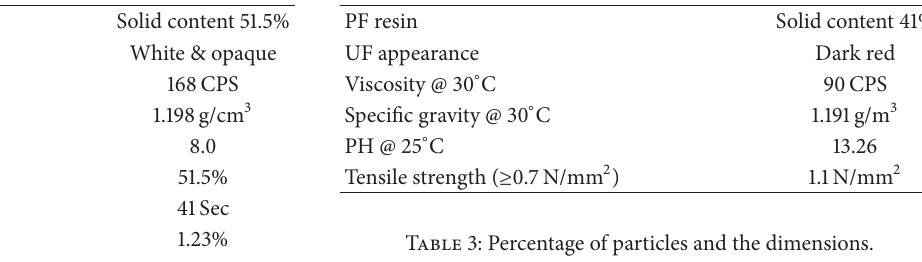
Table 2: Specification of PF.